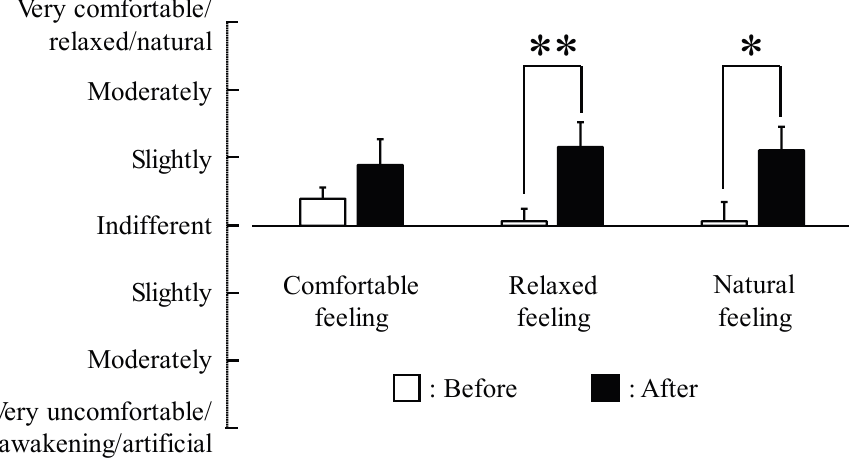
Figure 5. Semantic Differential (SD) method scores before and after forest therapy. Changes